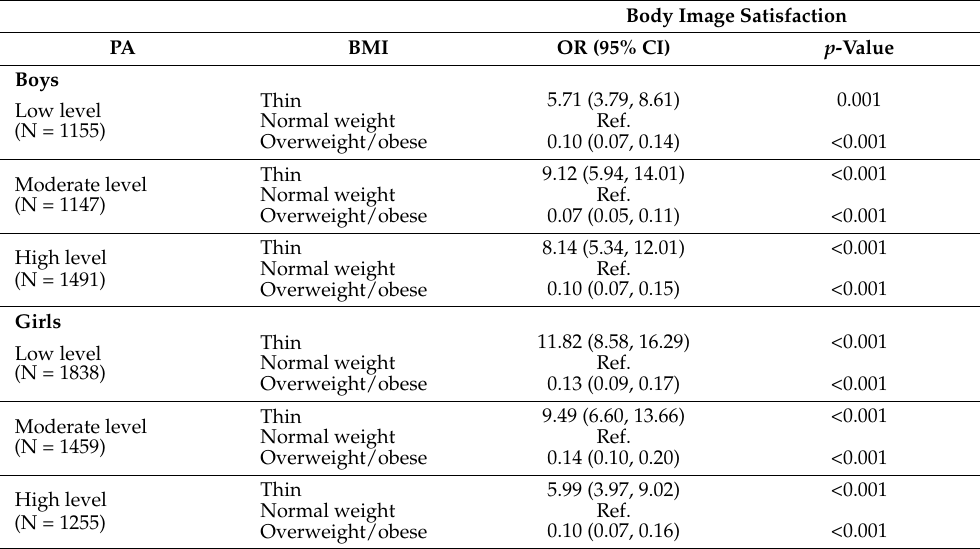
Figure 1. Odds ratios with their 95% confidence intervals showing the risk for wishing for a bigger body compared to being satisfied or wishing for a smaller body in different body mass index (BMI) and physical activity levels separately for boys ( A ) and girls ( B ). Normal weight and ≥ 9 h/week are reference groups. Table 4. Associations of body mass index with body image satisfaction stratified by physical activity (PA)